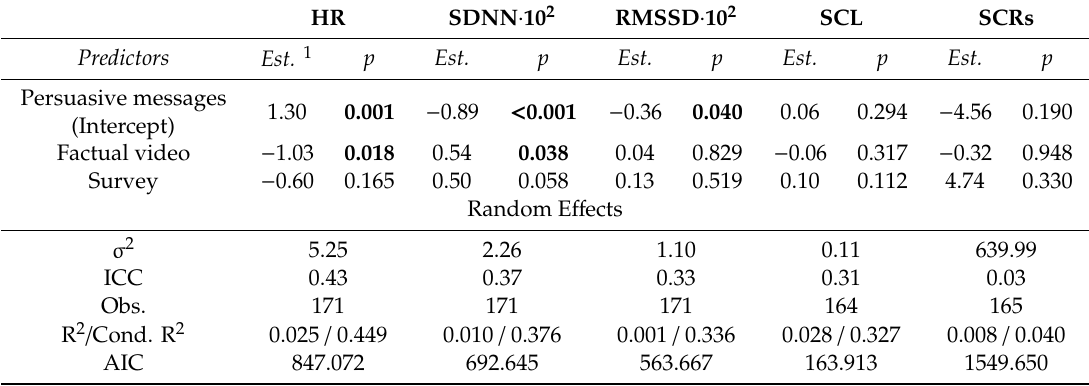
Table 4. Summary results of the mixed linear models for reactivity of Heart Rate (HR), Heart Rate Variability (standard deviation from normal-to-normal peaks (SDNN) and root mean square of successive di ff erences (RMSSD)) and Electrodermal (skin conductance level (SCL) and skin conductance responses (SCRs)) per